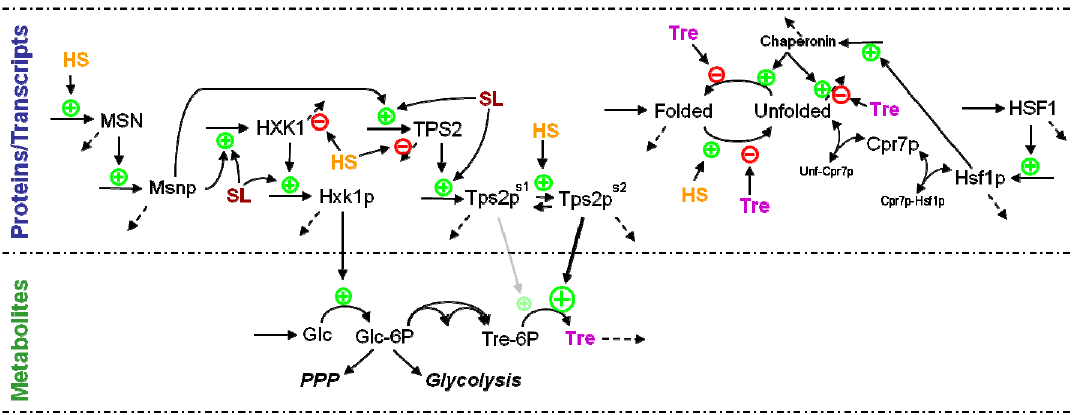
Figure 6. Schematic overview of the multi-scale regulatory model of the heat stress response. Heat stress (HS) increases the expression of the transcription factor MSN, which in turn regulates genes that code for enzymes of central metabolism that are involved in the cell’s protection against protein unfolding (e.g., hexokinase and trehalose-6P phosphatase). Additionally, the expression of these MSN-induced genes is coordinated by sphingolipids (SL), whose pathway dynamics is directly affected by heat. Furthermore, heat stress increases the half-lives of transcripts, as well as the activity of Tre-6P phosphatase. The presence of heat-unfolded proteins releases the inhibitory effects of Cpr7p on Hsf1p, thus up-regulating the expression of HSF and of chaperonins, which in turn promotes the refolding of unfolded proteins. Trehalose acts as a protein stabilizer. Dashed arrows depict degradation